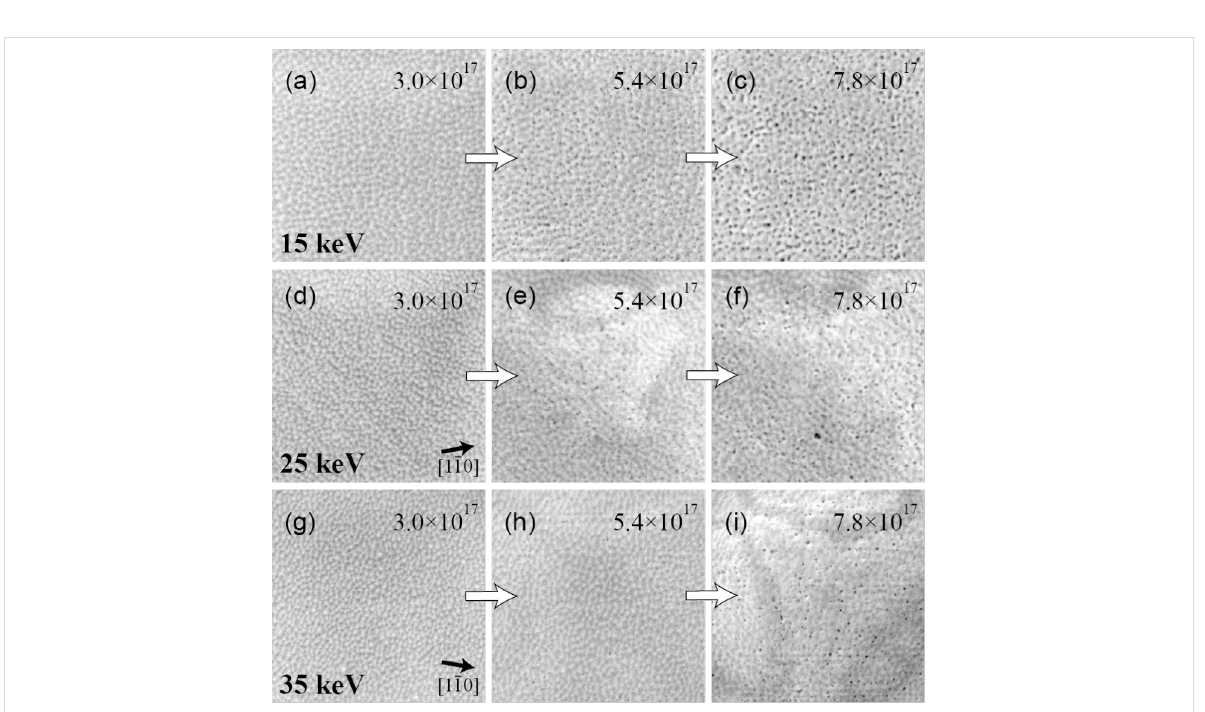
Figure 2: HIM SE images of the pattern that develops on the Au{111} surface as a function of ion fluence. Numbers indicate the ion fluence in helium ions per cm 2 . Arrows in (d) and (g) indicate the azimuthal directions of the grains. The He + beam energies are 15, 25 and 35 keV. FOV is 500 nm, pixel spacing is 0.68